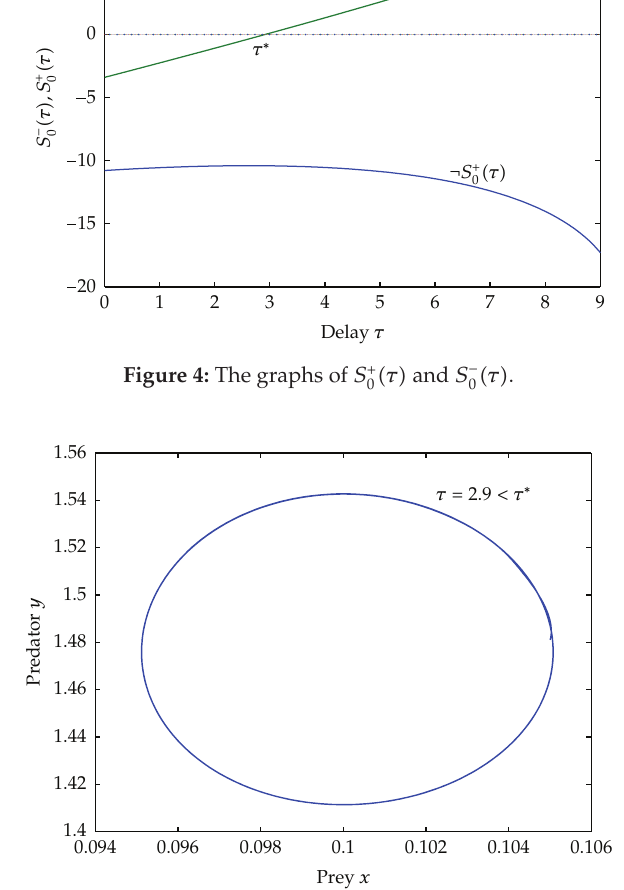
Figure 5: The bifurcating periodic solutions from E when τ (cid:6) 2 . 9 < τ ∗